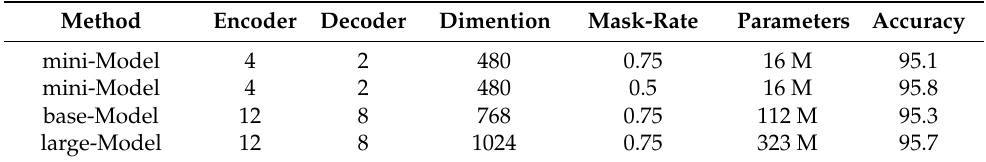
Table 7. Comparison of different size of our model.